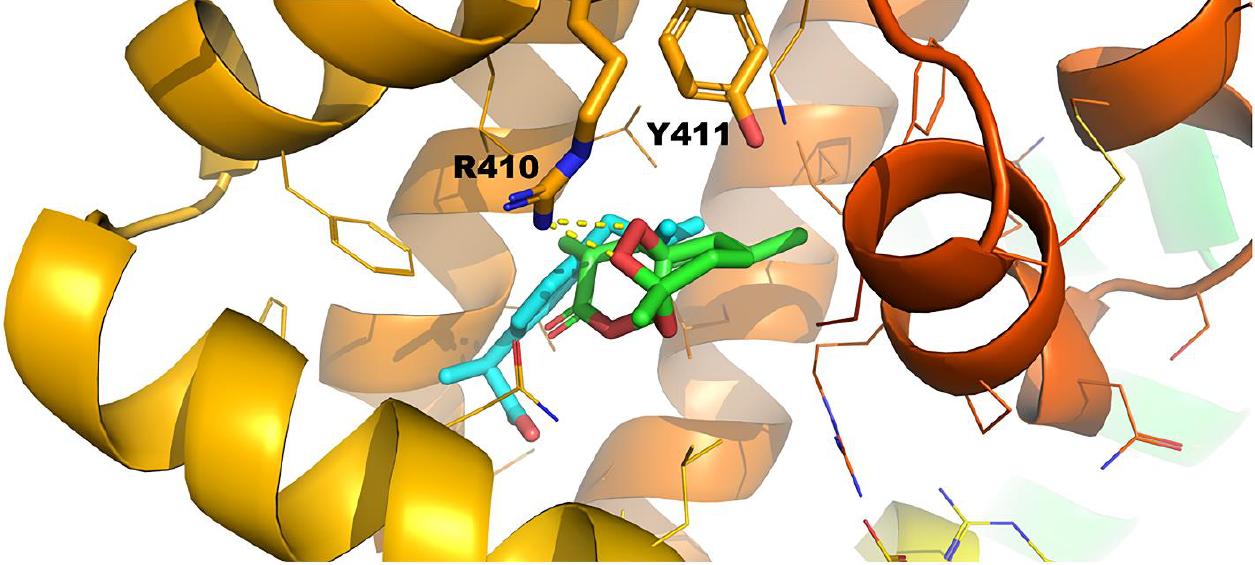
Figure 10. Superimposed pose number 1 of ibuprofen and artemisinin for binding site FA4 of HSA (1BXG.pdb).